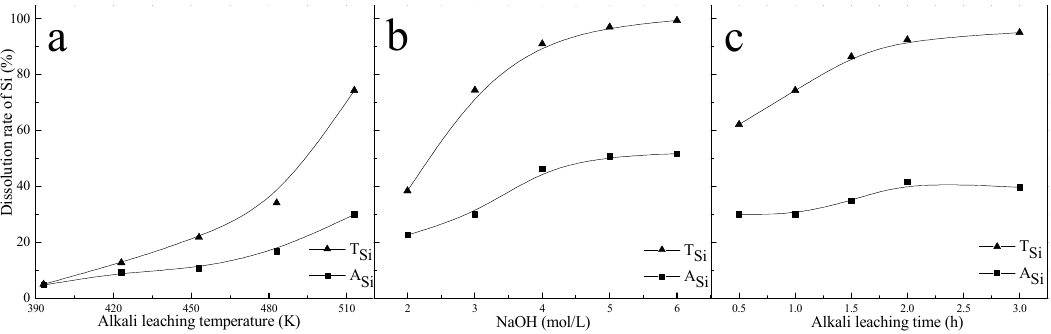
Figure 2. Effect of ( a ) alkali leaching temperature; ( b ) alkali concentration and ( c ) leaching time on dissolution of sericite. dissolution of